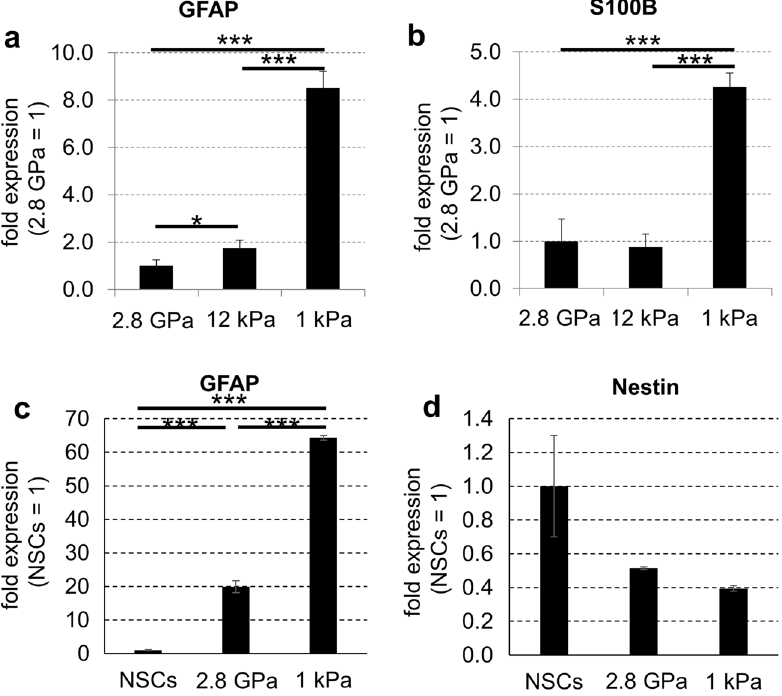
Figure 2. Soft surfaces increase mRNA expression of astrocyte markers and decrease mRNA expression of NSCs marker after 3 days of differentiation of mouse embryonic neural stem cells in the absence of serum. Mouse embryonic NSCs were cultured on three types of plates (1 kPa plates, 12 kPa plates, and commonly used plastic plates [2.8 GPa]) for 3 days in serum-free conditions. The mRNA expression of GFAP, S100B, and GAPDH on each plate type was detected by qPCR analysis. The expression levels of ( a ) GFAP and ( b ) S100B were normalized relative to that of GAPDH. Mouse embryonic NSCs were cultured on two types of plates (1 kPa plates and commonly used plastic plates [2.8 GPa]) for 24 h in serum-free conditions. The mRNA expression of GFAP, Nestin, and GAPDH on each plate type and pre-seeding NSCs were detected by qPCR analysis. The expression levels of ( c ) GFAP and ( d ) Nestin were normalized relative to that of GAPDH. Error bars represent the standard deviation; * p < 0.05, *** p < 0.005 (Student’s t test with Bonferroni correction). NSCs neural stem